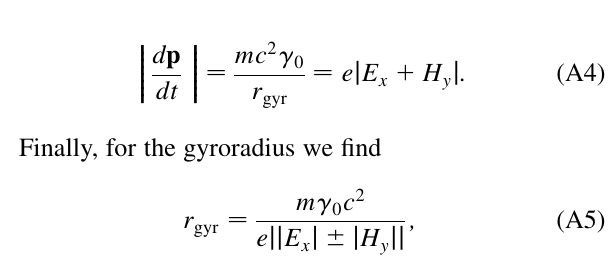
FIG. 6. Electron trajectory in the